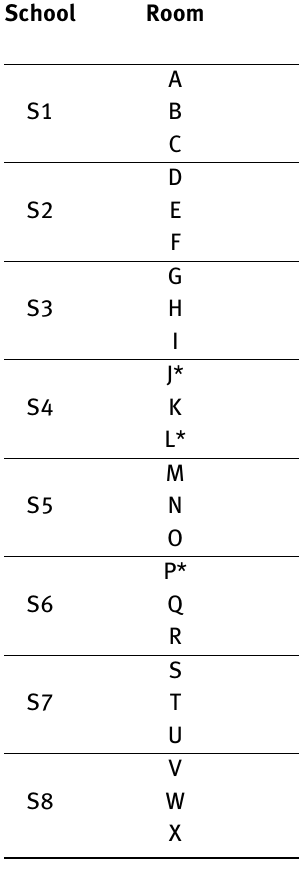
Table 7: Acoustical characteristics of the classrooms: reverberation time and STI index. (*) a false ceiling was